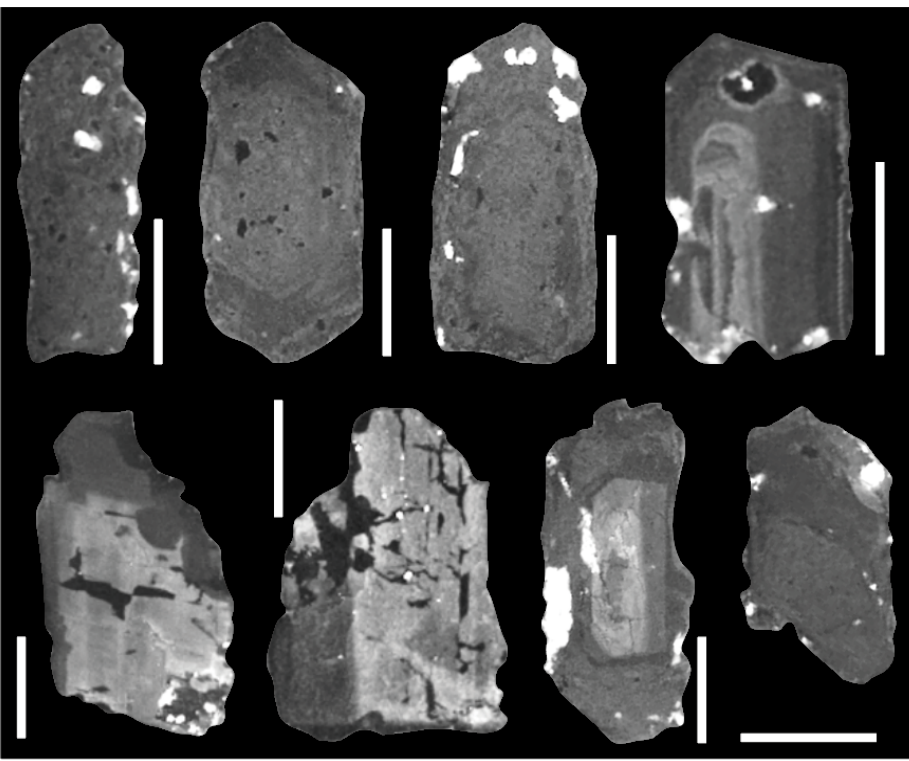
Figure 5. Cathodoluminescence images of selected zircon grains of the D1A sample. The scale (white rectangle) measures 50 μ m.